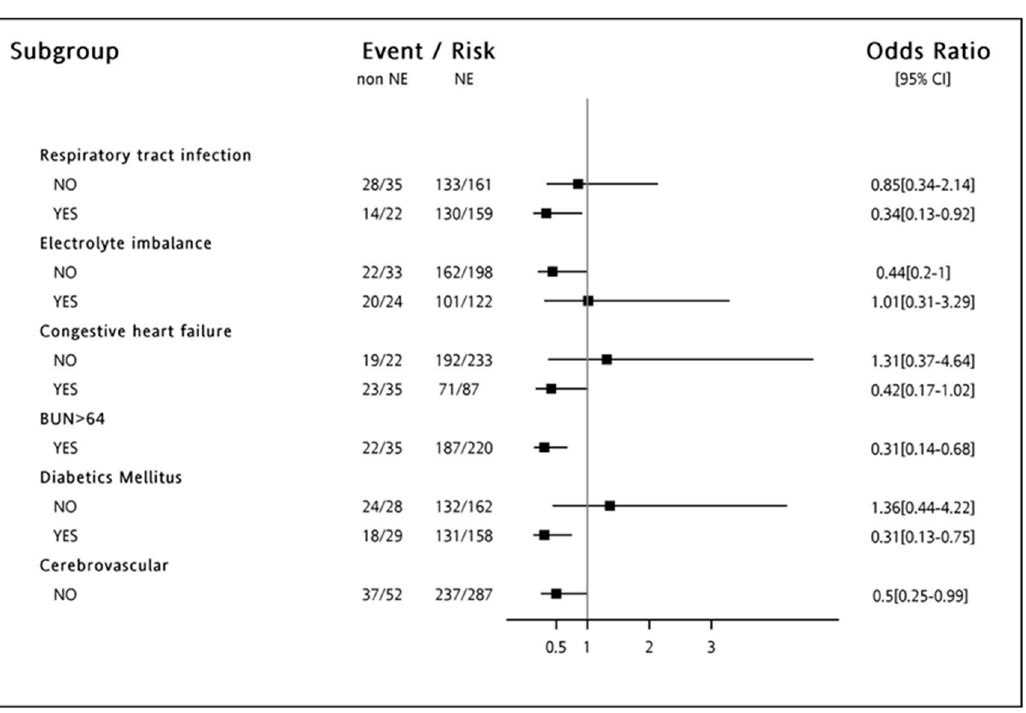
Figure 1. Odds ratio of Norepinephrine user on the development of 90 days mortality. Odds ratio of Norepinephrine users (vs. other vasoactive agents) on the development of 90-day mortality, according to demographics in septic shock patients at dialysis initiation. Patients those who had respiratory tract infection, congestive heart failure, diabetes mellitus, BUN with more than 64 mg/dL, and did not have cerebrovascular disease tended to have a higher 90-day mortality while norepinephrine (NE) was prescribed.